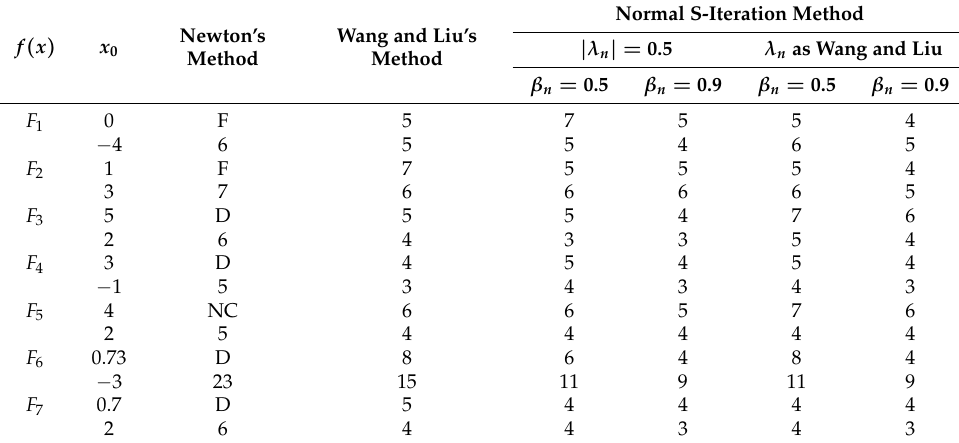
Table 1. Functions for which third-order differentials